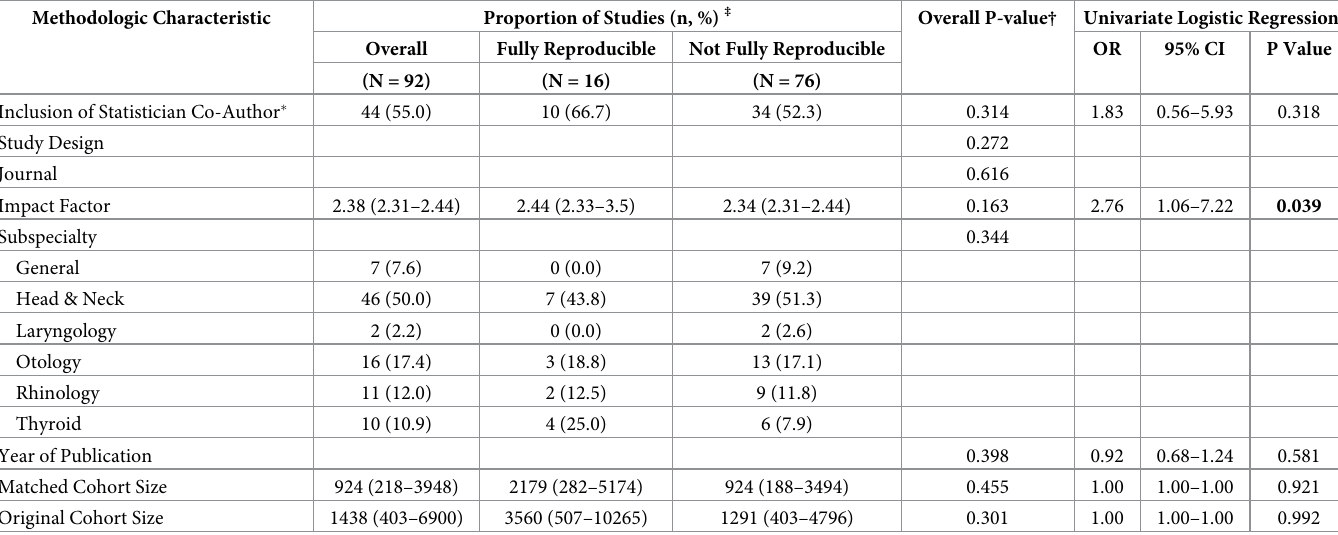
Table 4. Associations between bibliometric factors and PSM reproducibility. Methodologic